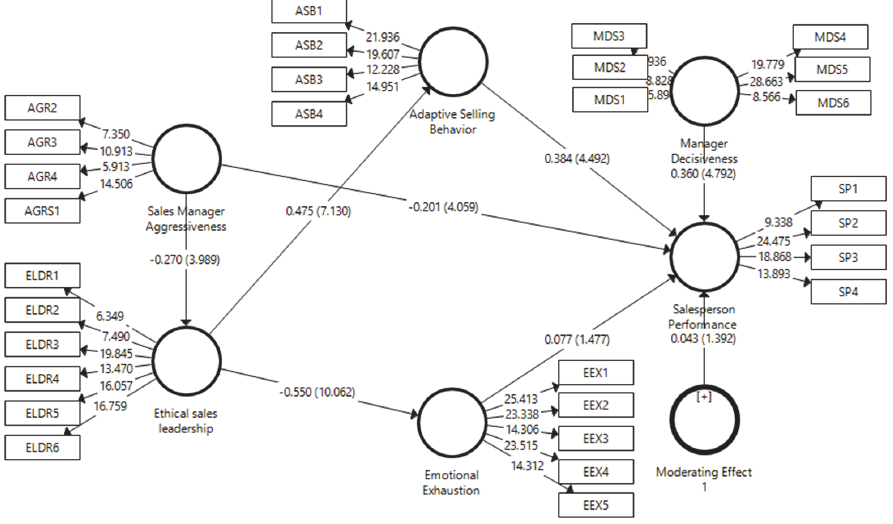
Fig. 2. Full structural model with beta ( β ) and t